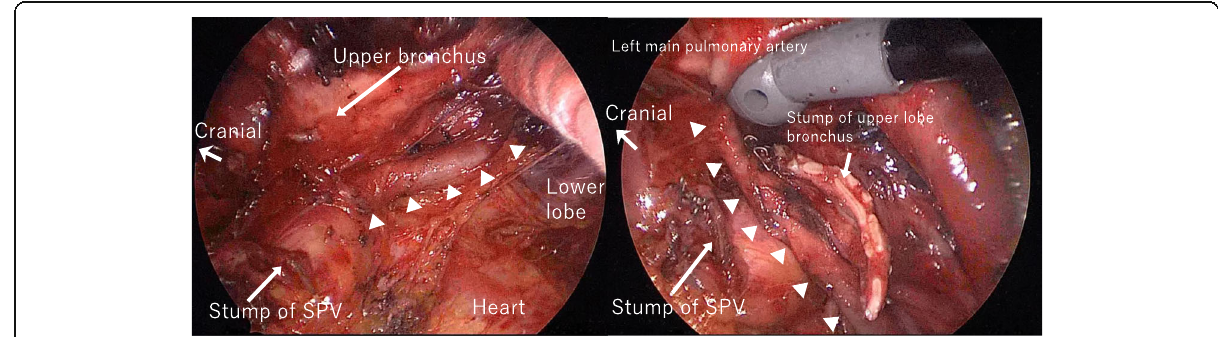
Fig. 2 Intraoperative findings. Pulmonary artery branch from the left main pulmonary artery to S8 is between the stump of the superior pulmonary vein (SPV) and the upper lobe bronchus (white arrowheads)